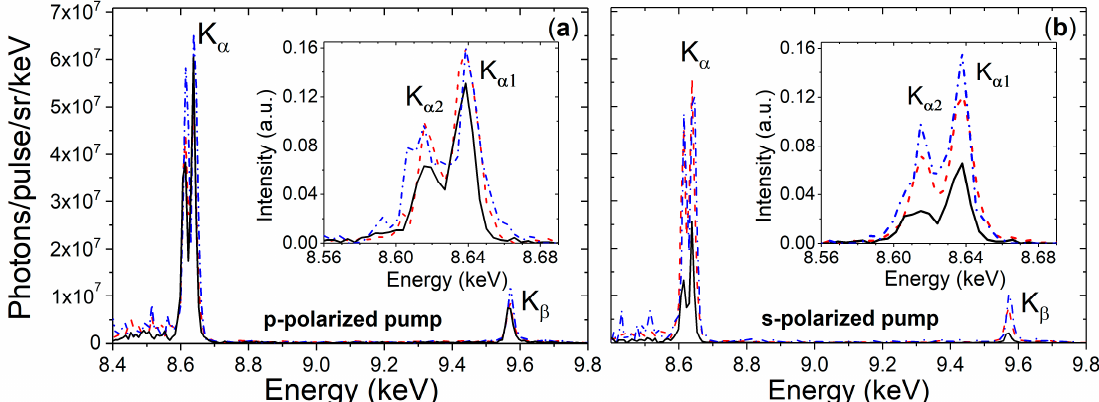
Figure 6. The K-shell emission and K α doublet (insets) from ZnO targets (flat (black line), ordered NW (red line), and disordered NW (blue line)) detected with LiF (220) and quartz (40-4) bent crystal spectrometer, respectively. The spectra were obtained from interaction with a p-polarized ( a ) and s-polarized ( b ) laser beam. Table 1. The mean values of the integrated Zn K α emission for the investigated targets obtained with p- and s-polarized laser pulse. The values are normalized on the integrated Zn K α flux from the flat